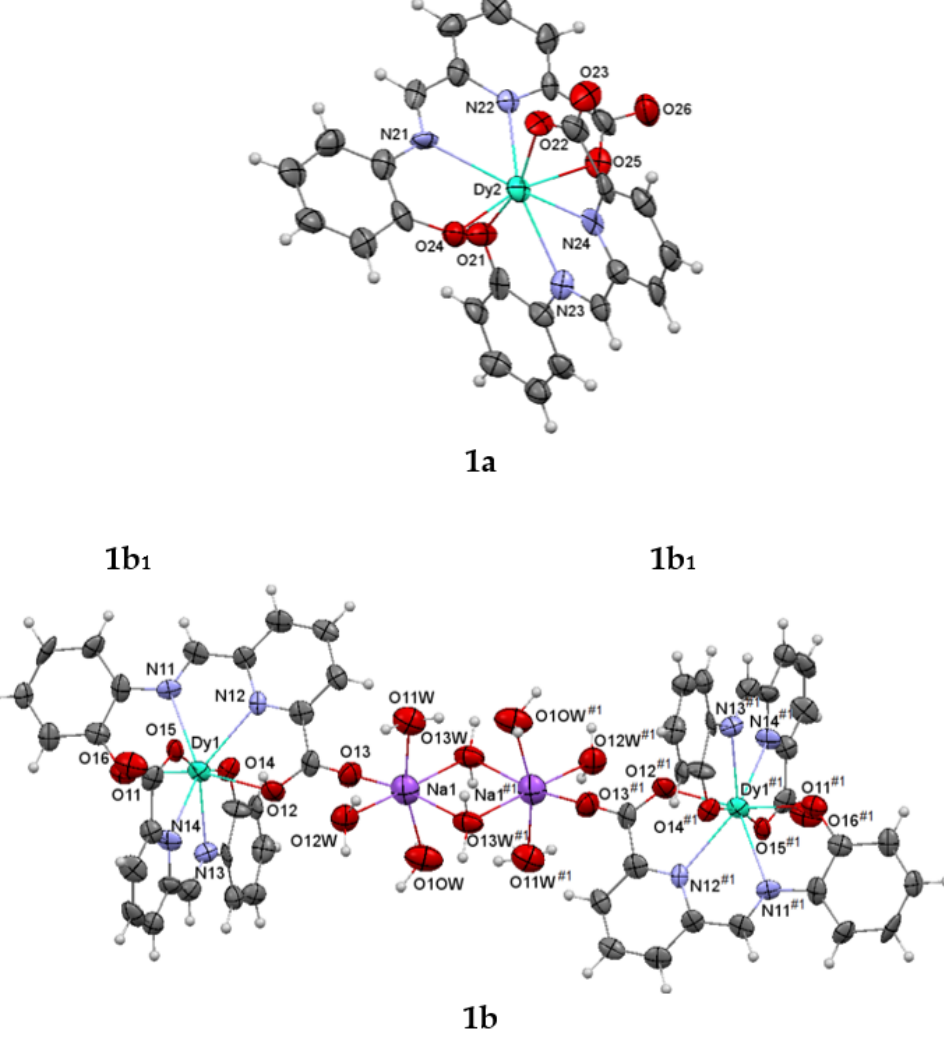
Figure 1. Ellipsoid (50% probability) diagram for the anion [Dy(L) 2 ] − ( 1a ) and the moiety [(DyL) 2 Na 2 (H 2 O) 8 ] ( 1b ) in 1. Water solvate and Et 3 N + cations are omitted for clarity. Table 1. Main bond distances (Å) and angles (º) for 1.